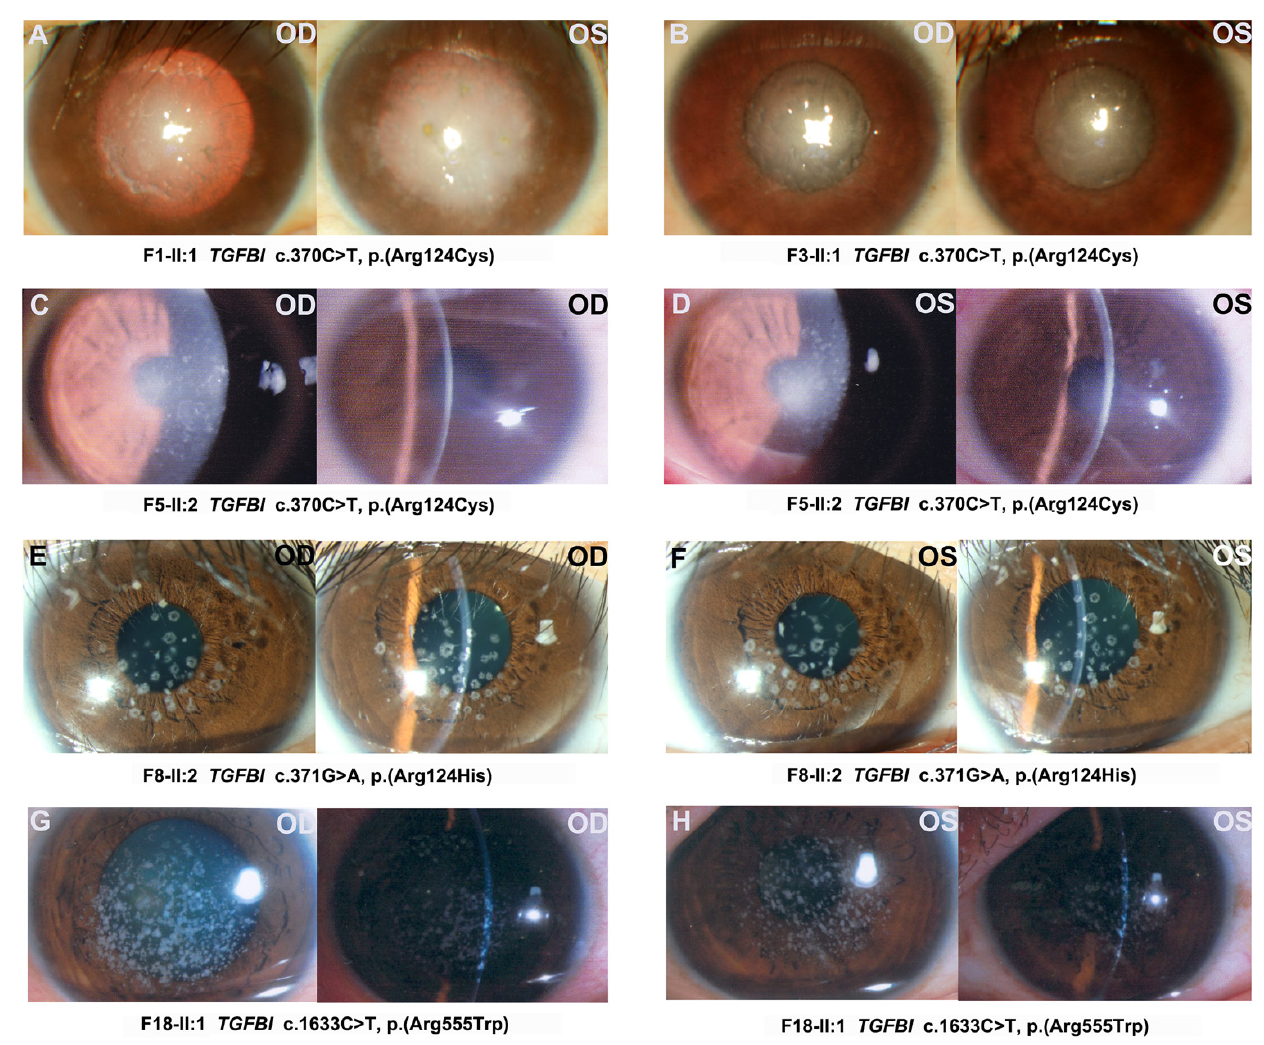
Figure 3. Representative slit-lamp photographs of patients with pathogenic or likely pathogenic variants in TGFBI . ( A – D ) Patients who showed the phenotype of lattice corneal dystrophy with the same variant, c.370C>T, p.(Arg124Cys). Lattice lines and dot-shaped deposition can be seen in